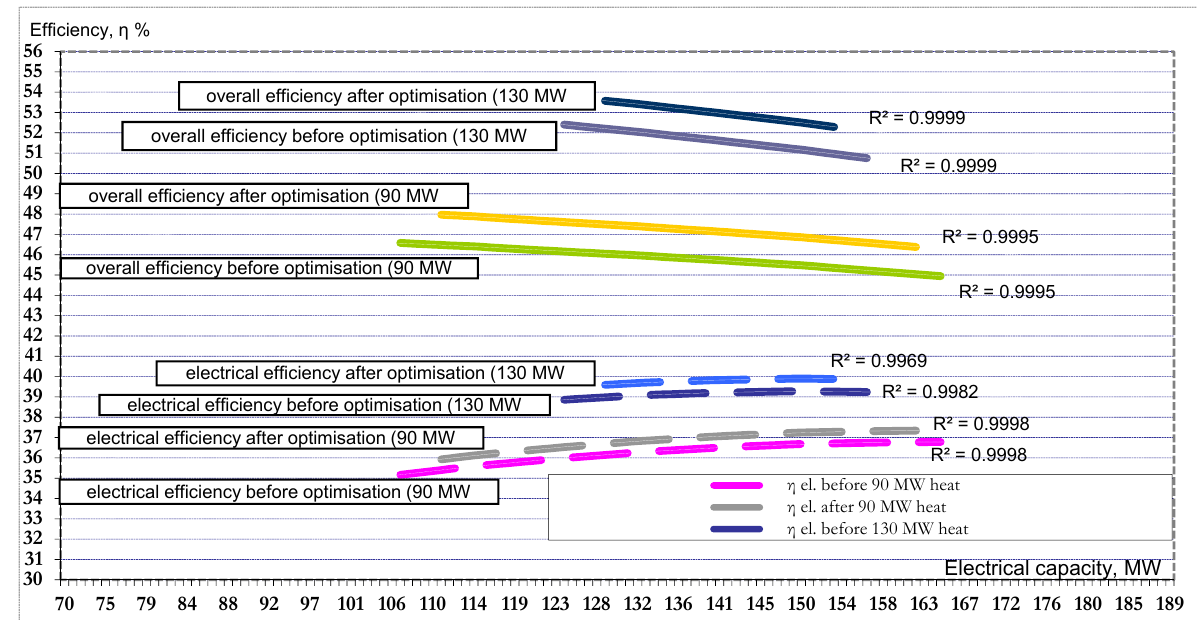
Figure 11. Efficiency optimisation result for an average 90 MW and maximum 130 MW heat demand.